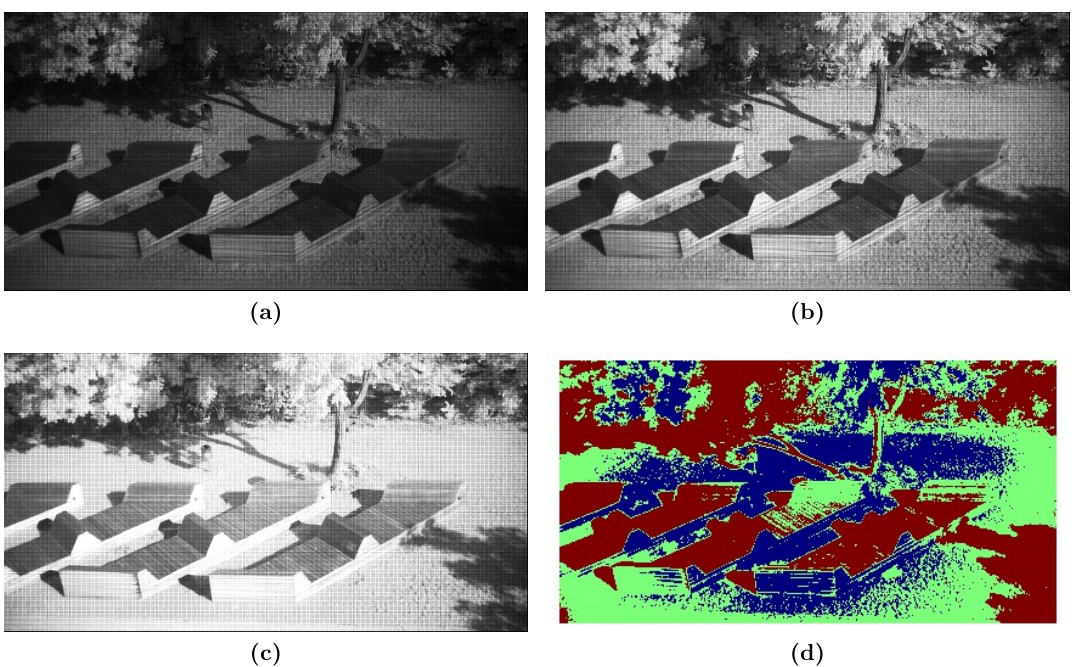
Figure 6. Visualization of our high dynamic range (HDR) solution for hyperspectral frames with exposure times of ( a ) 1 ms, ( b ) 2 ms, and ( c ) 4 ms. ( d ) Combined HDR mask with mosaic patterns selected from ( a ) blue; ( b ) green; and ( c )